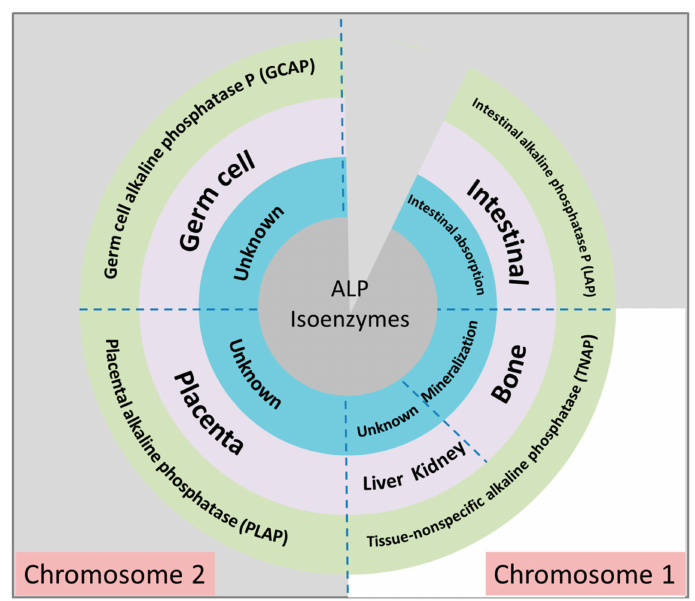
Figure 2. ALP isoenzyme with common names, place function limitation